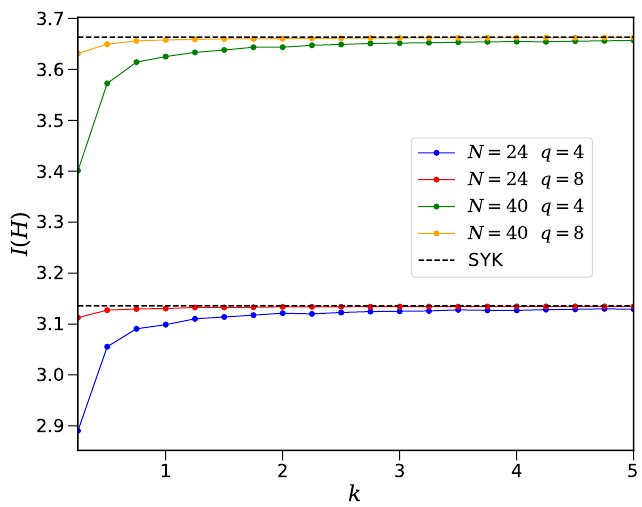
Figure 2. Algebraic hypergraph entropy I ( H ) as a function of the sparsity parameter k for a ( kq, q ) -regular hypergraph generated randomly using algorithm 1. The entropy is obtained from the eigenvalues of the rescaled Laplacian matrix